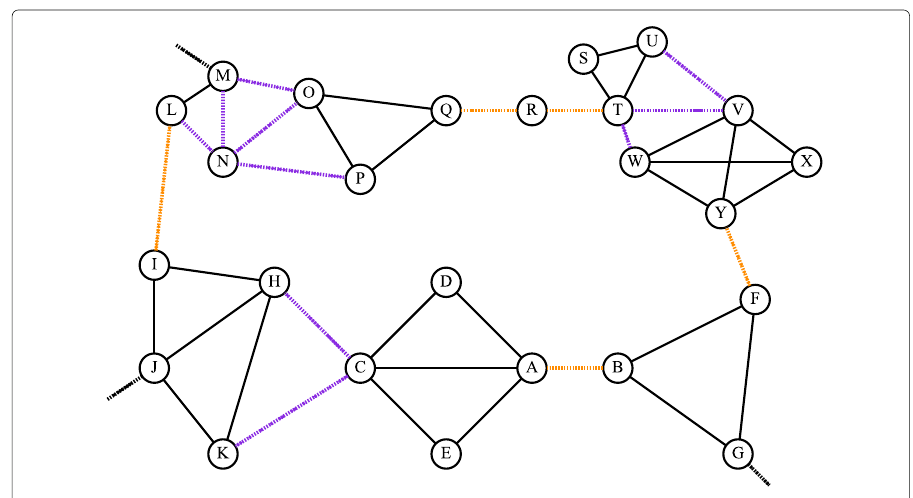
Fig. 8 Granovetter’s 1973 Example B